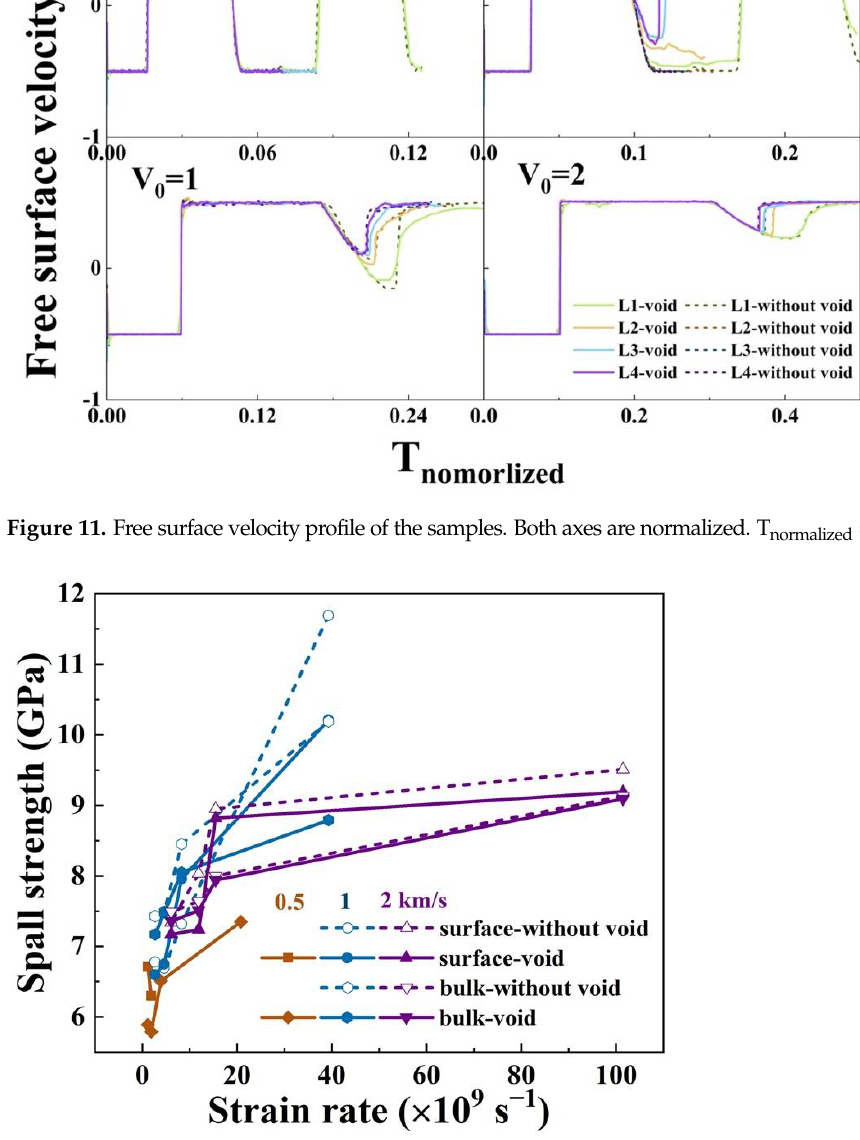
Figure 12. Spall strength of samples at different impact velocities and strain rates, the dotted line represents single-crystal aluminum without a preset void, and different colors represent different impact velocities. The spallation strength from the free surface velocity approximation and directly obtained from the stress profiles is